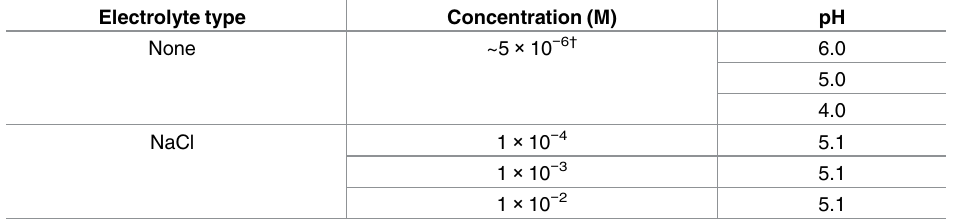
Table 3. Electrolyte type, concentration and pH of solutions used in the force measurements with